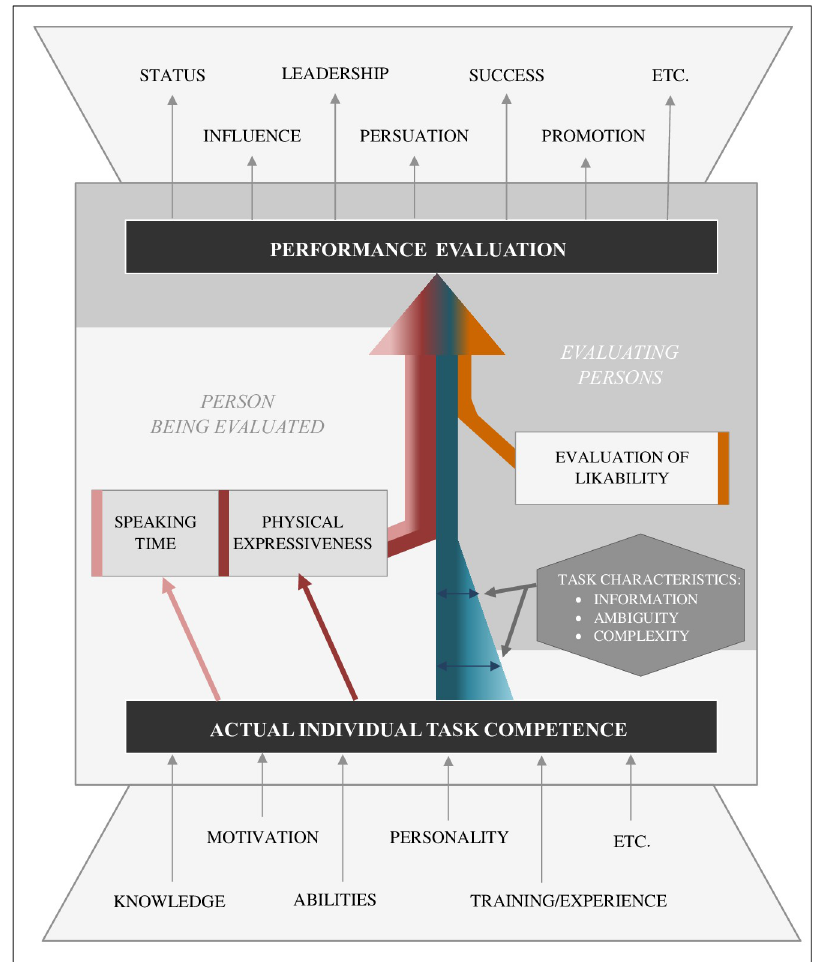
Fig 1. Framework for the performance evaluations in the group